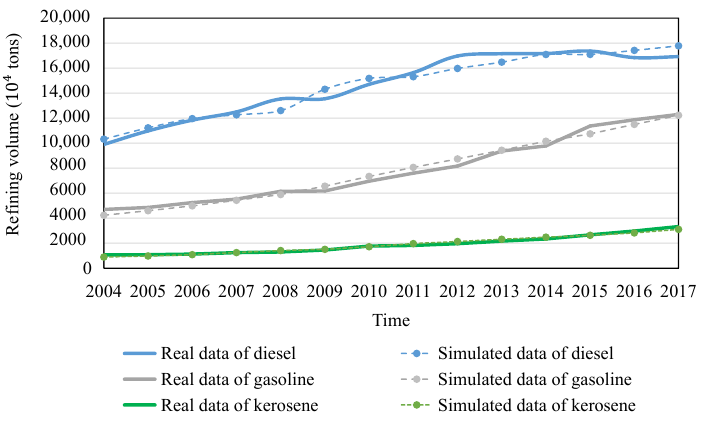
Figure 11. Compare the volume of diesel refining, gasoline refining, and kerosene refining with real data and simulated data.